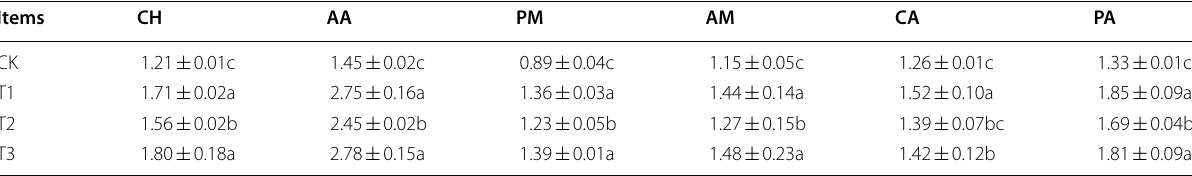
Here CH carbohydrates, AA amino acids, PM polymers, AM amines, CA carboxylic acid, PA phenolic acids According to Duncan’s multiple range test, different small letters in the same column show significant differences among treatments at P < 0.05 Table 5 Diversity index of soil microbial communities under different treatments